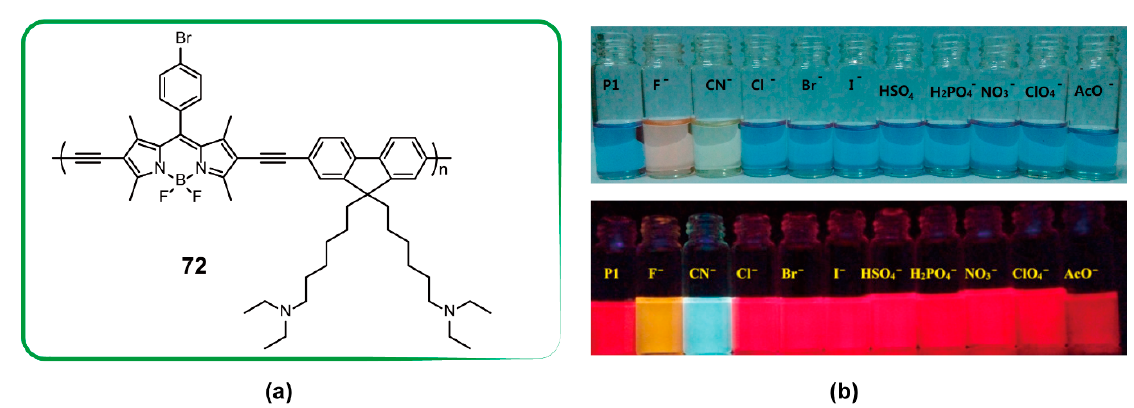
Figure 24. ( a ) Chemical structures of polymer 72 . ( b ) Visual color changes and emission changes ( λ ex = 365 nm) of 72 (c = 10 μ M) in tetrahydrofuran/H 2 O (98:2, v / v ) in the presence of different anions (Reproduced with permission from Reference